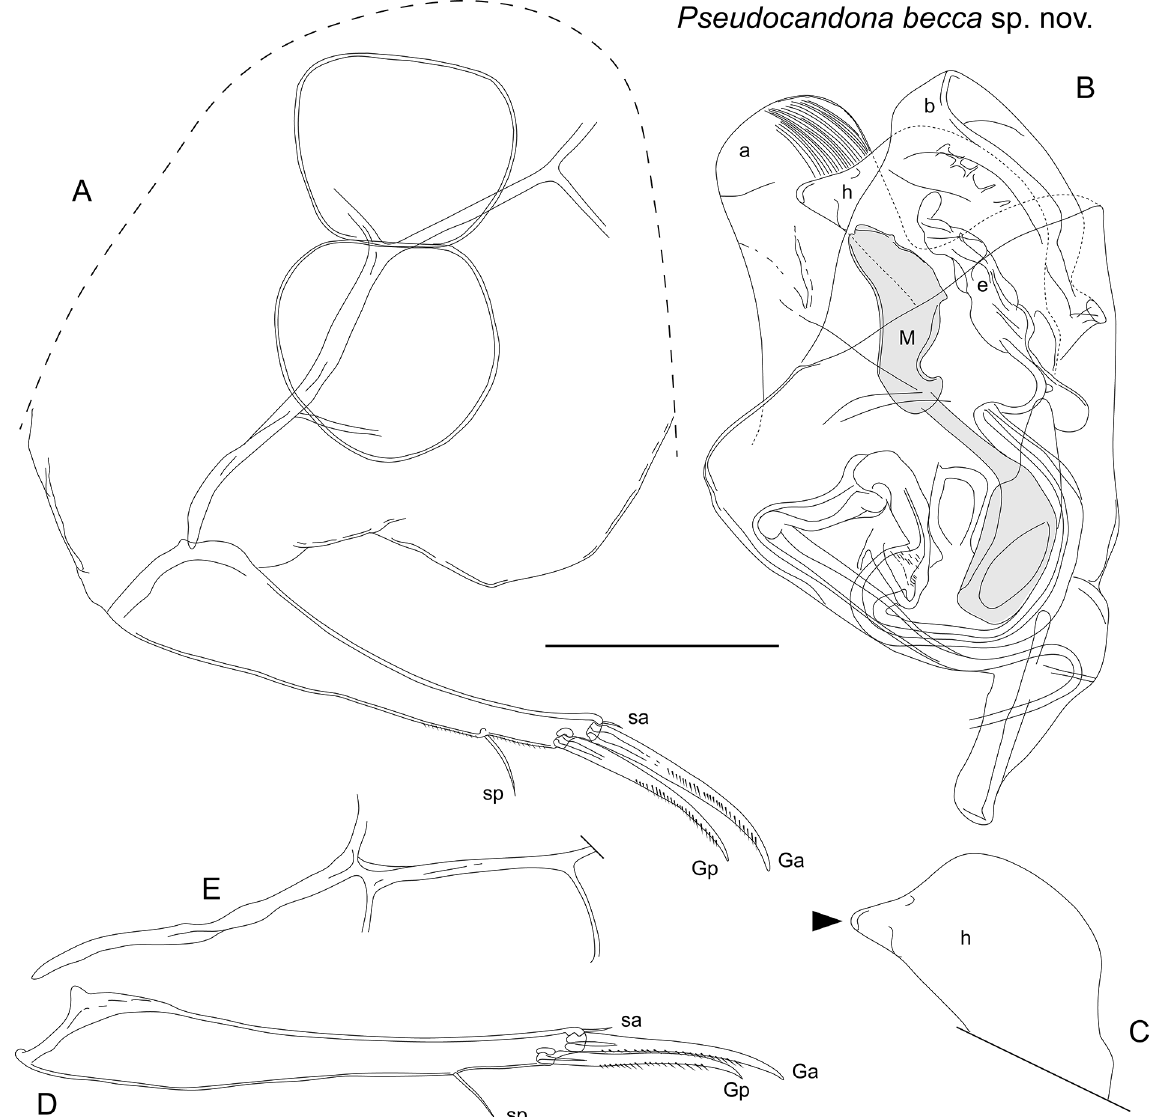
Fig. 5. Pseudocandona becca sp. nov. A . Caudal ramus and female genital lobe (LBM 1430006265). B . Hemipenis (LBM 1430006264). C . Detail of lobe h of hemipenis (LBM 1430006264), black triangle marks protrusion (see text for explanation). D . Male caudal ramus (LBM 1430006264). E . Male caudal ramus attachment (LBM 1430006264). Scale bar = 127